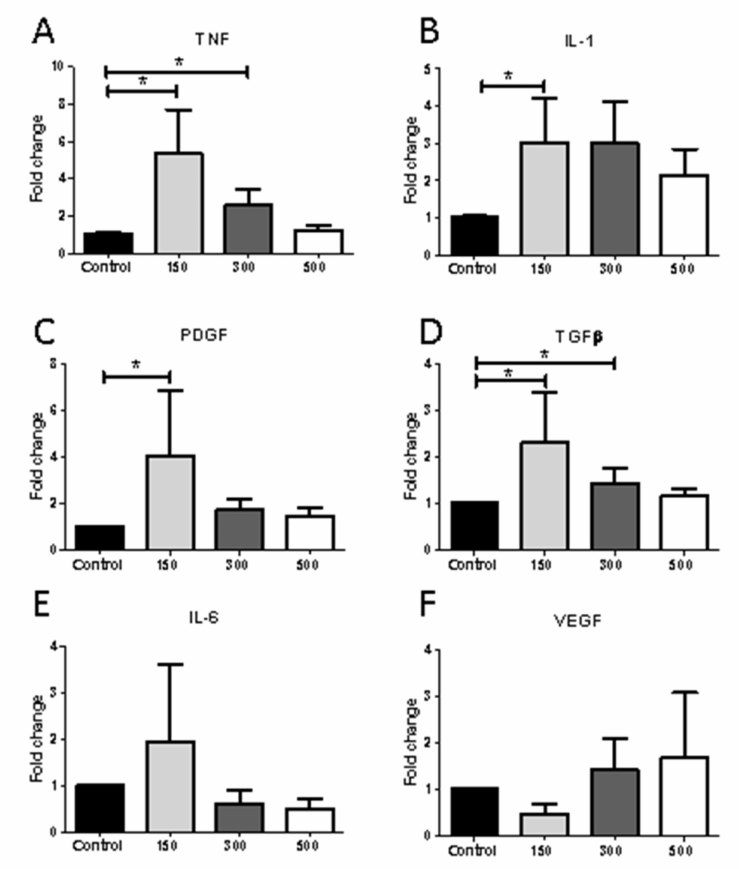
Figure 6. Shockwave stimulation selectively enhances macrophage mRNA expression. J774 macrophages were exposed to shockwave intensities of 150–500; 5 Hz, 0.1 mJ/mm 2 and after 4 h, macrophage gene expression levels of ( A ) TNF, ( B ) IL-1, ( C ) PDGF, ( D ) TGF β , ( E ) IL-6 and ( F ) VEGF, were analyzed by qPCR. Results were normalized on the housekeeping gene and expressed as fold enrichment compared to untreated control macrophages (control). Results are shown as mean ± SEM of 3–5 independent experiments, * p <